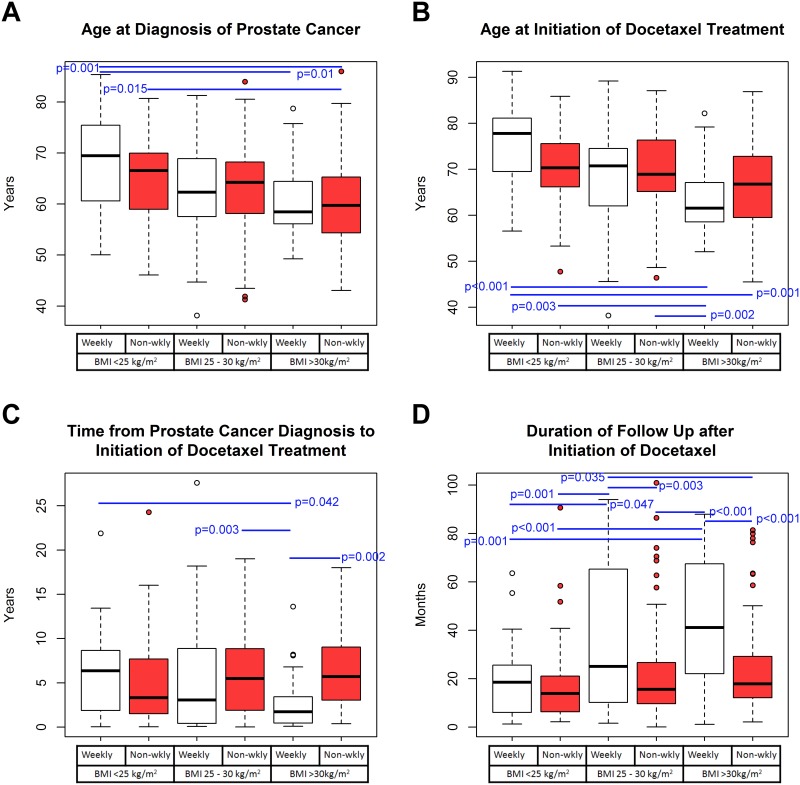
Time-related differences among groups of prostate cancer patients with different BMIs who received weekly docetaxel treatment or other docetaxel regimens.Box plots are shown for the following parameters: A) age at diagnosis of prostate cancer, B) age at initiation of docetaxel treatment, C) the number of years after diagnosis of prostate cancer when docetaxel treatment was initiated, and D) the number of months of follow-up starting from the initiation of docetaxel therapy. The black line inside each box represents the median, and outliers are represented by circles beyond the whiskers. The patient groups are as labeled beneath the horizontal axes. The groups that received weekly docetaxel regimens are shown in white, and those received other regimens are shown in red. The blue lines with P values labeled next to each indicate significant (P < 0.05) intergroup comparisons. The P values were based on non-parametric one-way ANOVA (Kruskal-Wallis) with post-hoc intergroup comparisons using the Tukey test.